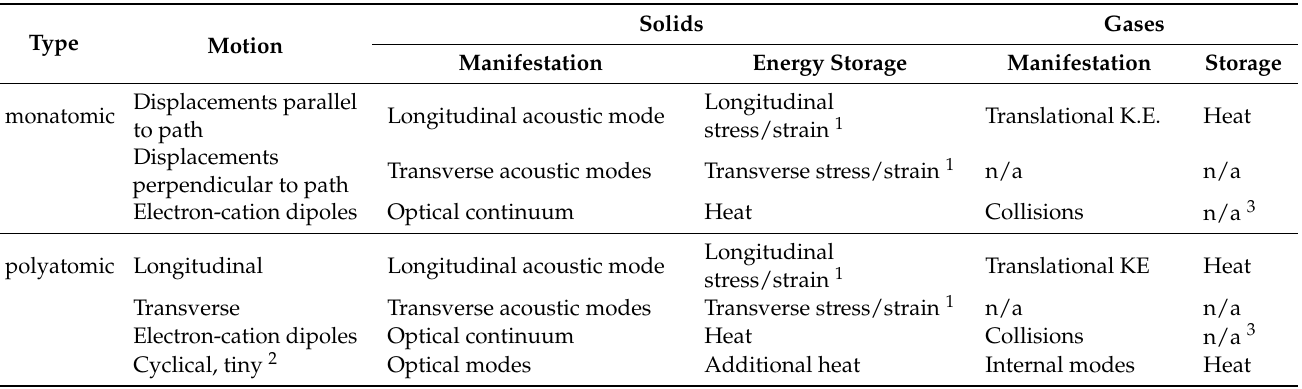
Table 2. Dependence of energy reservoirs on the state of matter and the complexity of its atomic